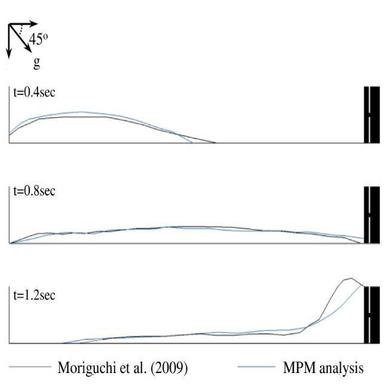
Deformed shape of granular flow for flume inclination equal to 45o .